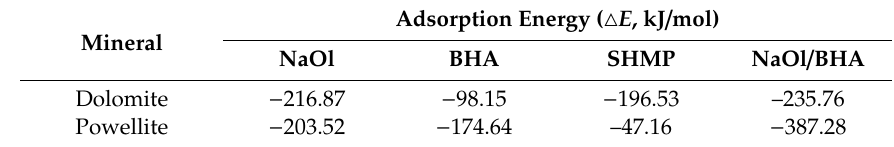
Table 4. Adsorption energies of minerals with reagents.